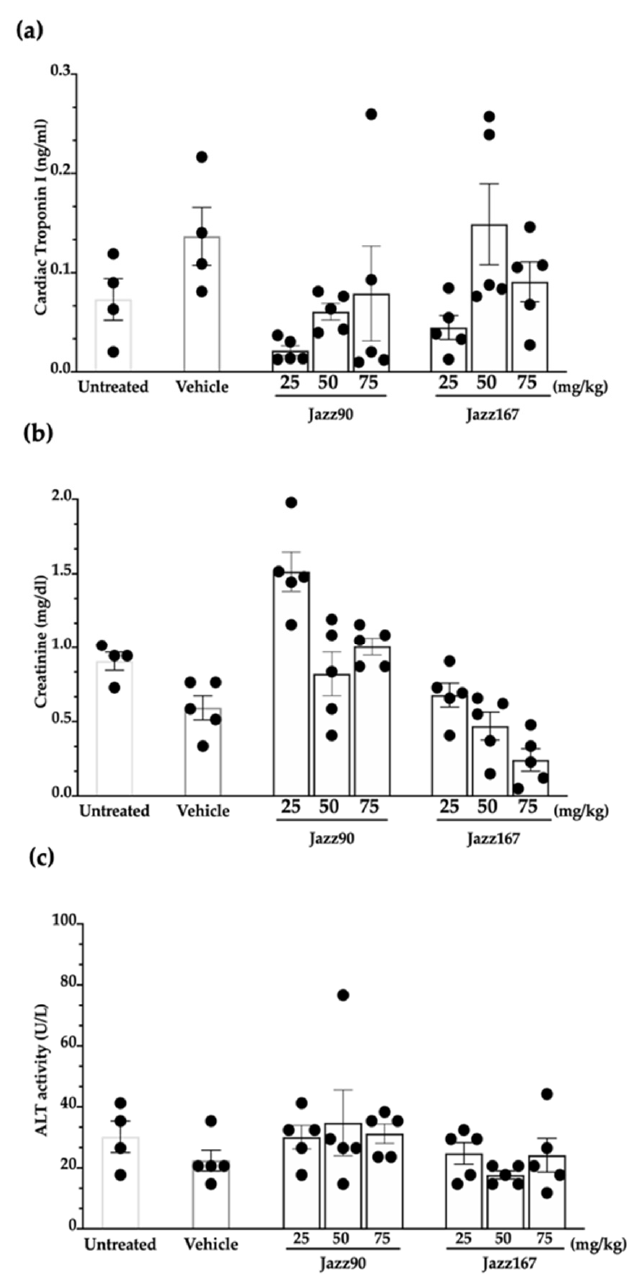
Figure 8. TnI, creatinine and ALT activity in BALB/c mice following compound treatment. Jazz90